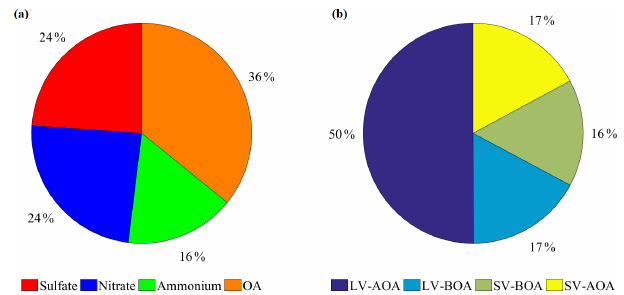
Figure 3. (a) The mean contribution of sulfate, nitrate, ammonium, and OAs to the mass concentration of SPs and (b) the mean con- tribution of LV-AOAs, LV-BOAs, SV-BOAs, and SV-AOAs to the mass concentration of OAs in SPs in September